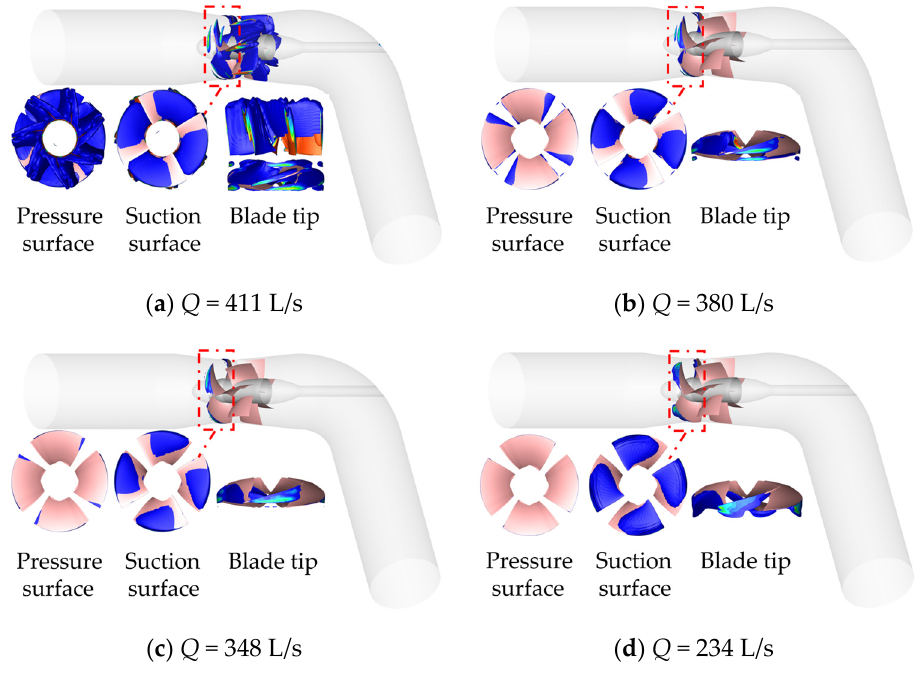
Figure 14. Air bubble distribution volume cloud diagrams at p in = 5 × 10 4 Pa.